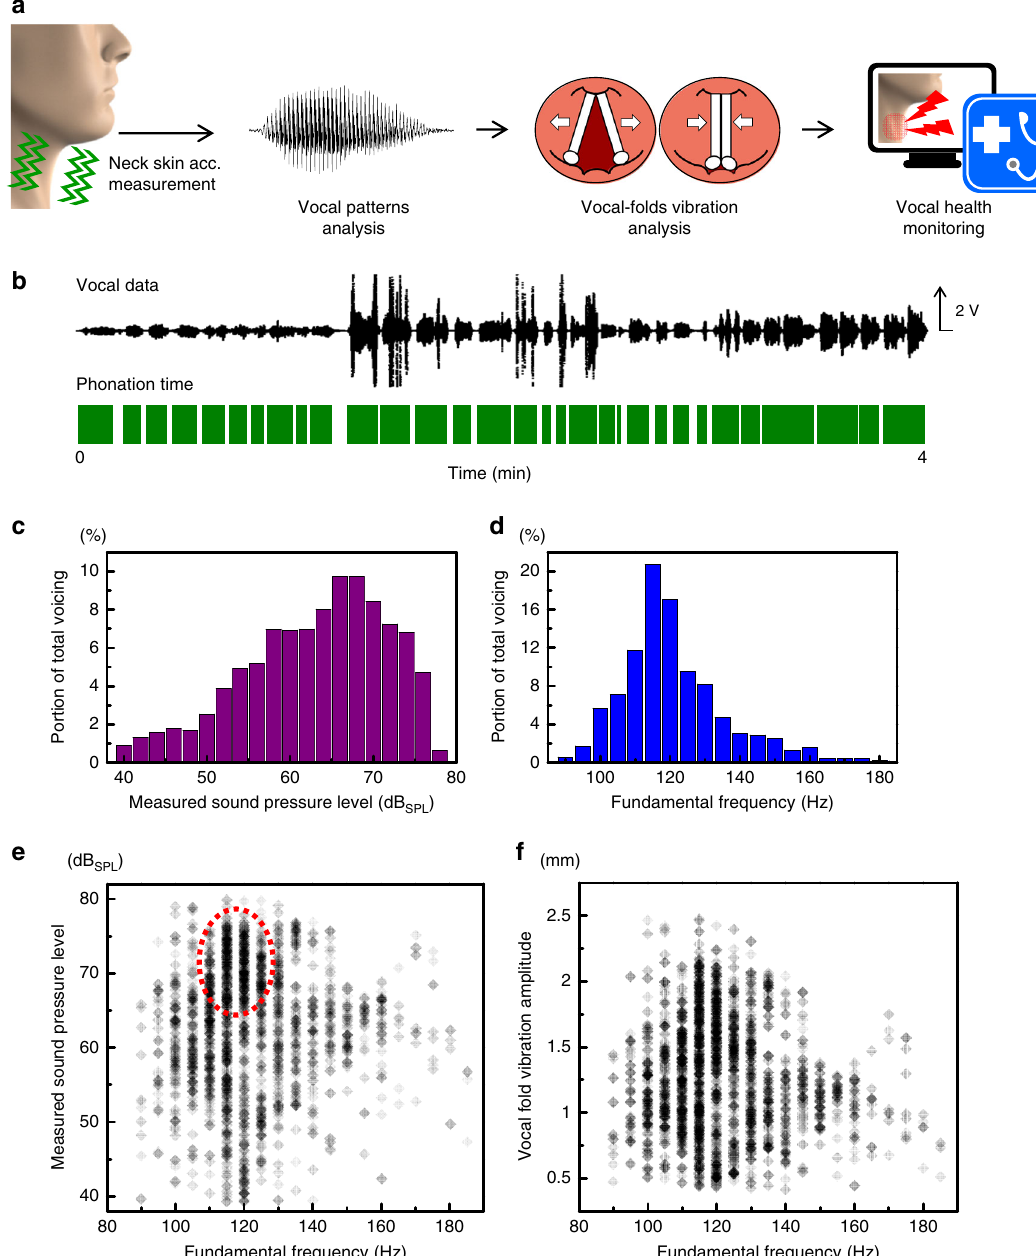
Fig. 6 Voice dosimetry by detecting neck skin vibration. a Schematic overview of voice dosimetry by measuring neck skin acceleration and analyzing vocal patterns. Human bust images in ( a ) were created based on a base-mesh, adapted with permission from https://www.deviantart.com/chrrambow/art/ Bust-Basemesh-128960722. Copyright 2009 by Christian Rambow. b Vocal waveform data measured by our device, and phonation time analyzed by dividing the vocal data into 100-ms intervals and distinguishing between speaking and non-speaking. c , d Histogram of sound pressure levels ( c ) and fundamental voice frequencies ( d ), each of which is extracted from the measured vocal data in ( b ). e The occurrence of particular combinations of fundamental frequency (horizontal axis) and sound pressure level (vertical axis) from the vocal data in ( b ). Dotted red circle represents the most frequent occurrence of this particular analysis example. f The amplitude of vocal fold vibrations as a function of fundamental voice frequency based on the vocal fold length and the measured sound pressure levels (see Supplementary Equation (12) in Supplementary Note